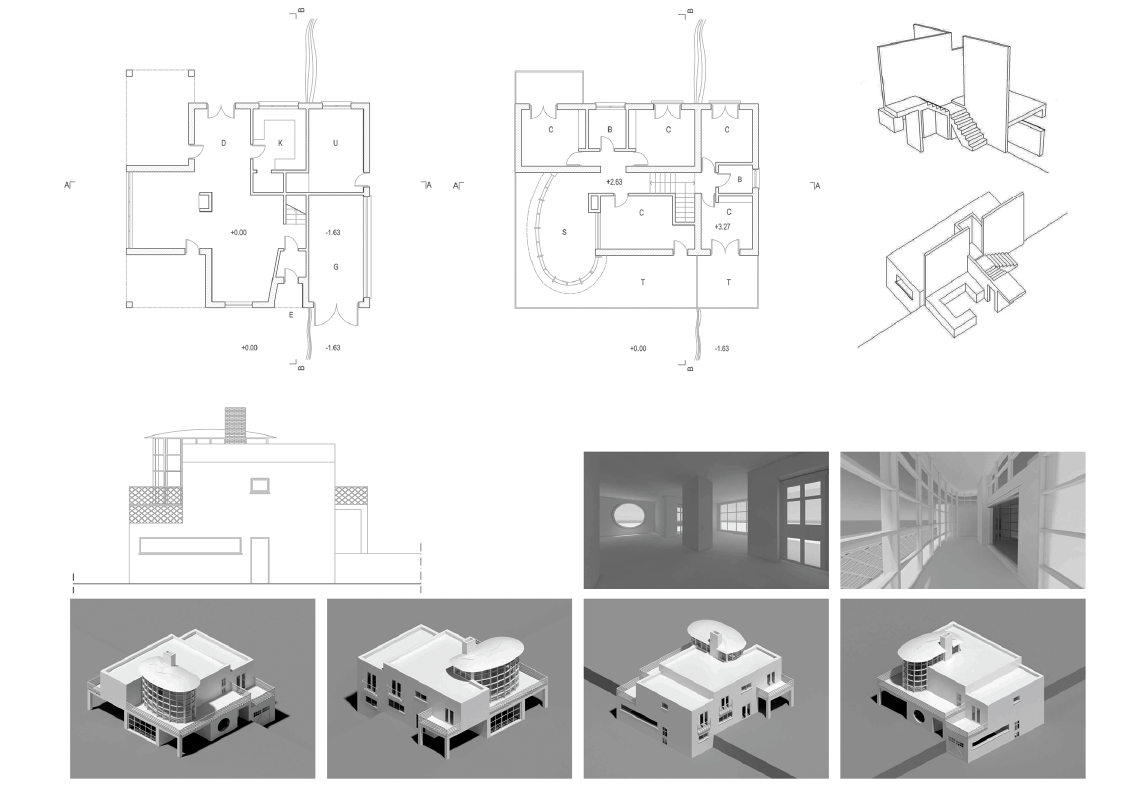
Figure 6. House 6. Plans, front, schemes, isometric views, perspectives (C.